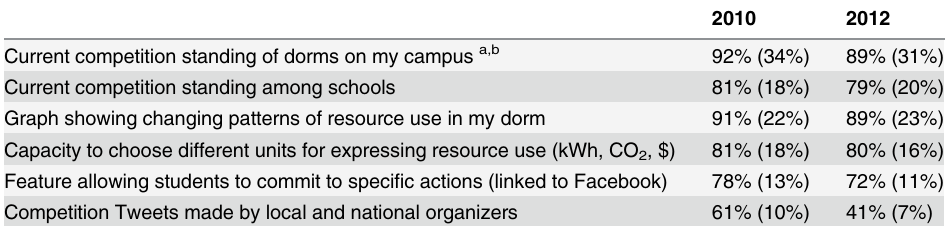
Table 2. Interest in different features of the